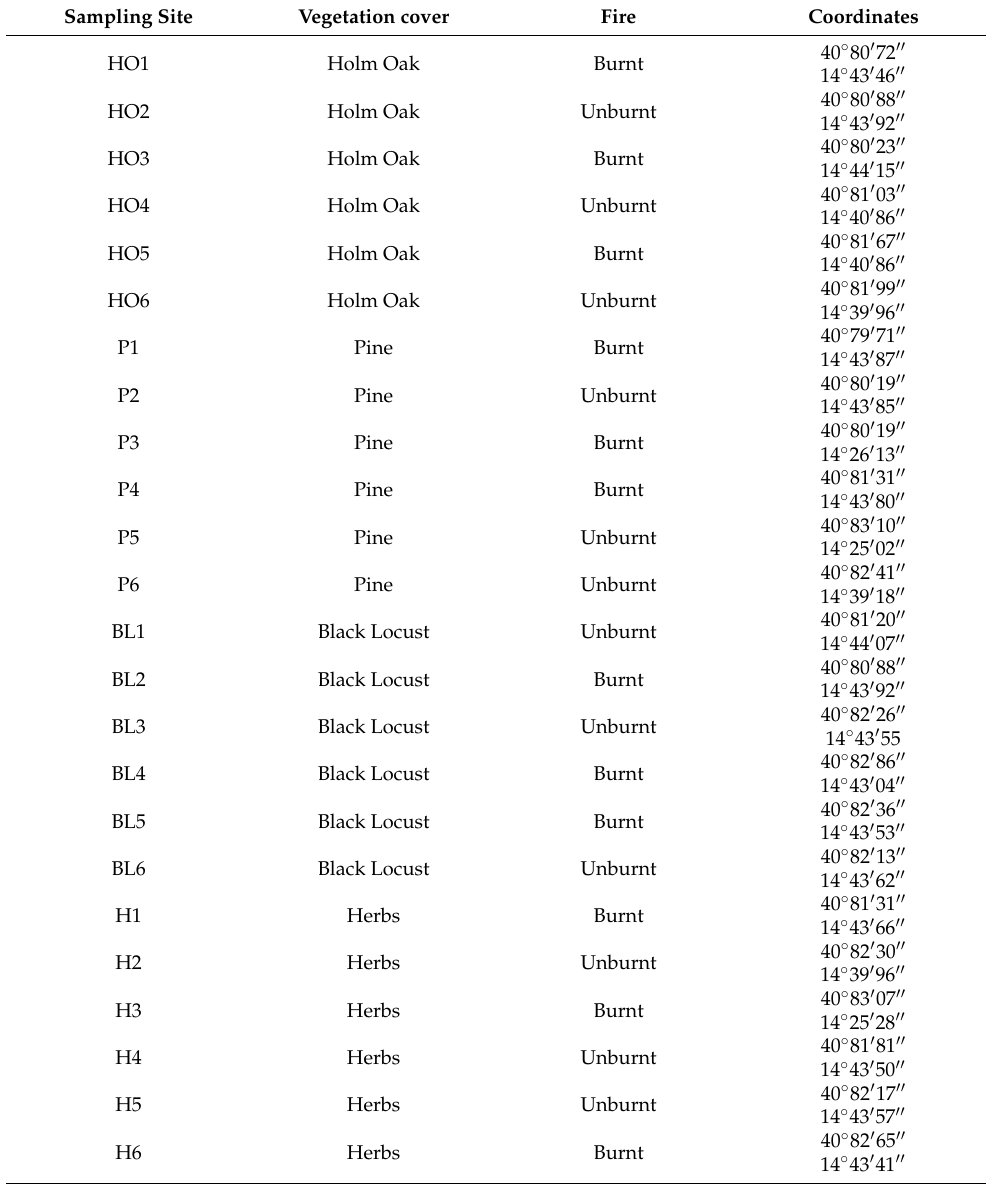
Table 1. Sampling sites collected in the investigated area. Site description of the unburnt and burnt soils sampled inside the Vesuvius National Park under different vegetation